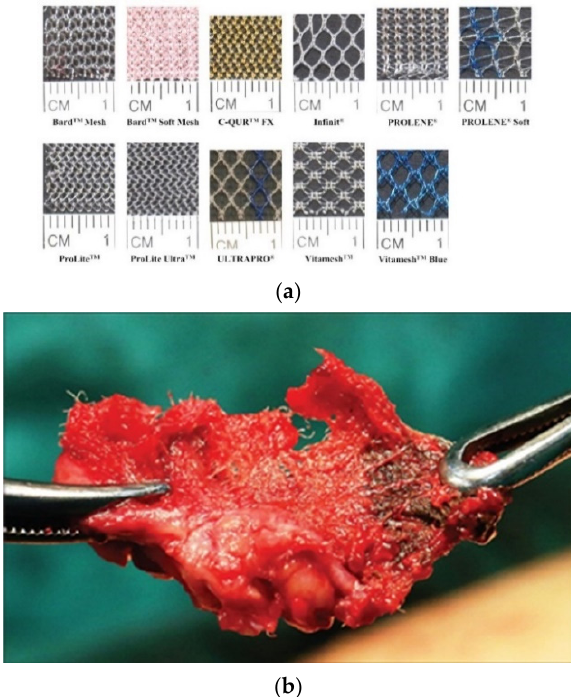
Figure 1. ( a ) Examples of different types of surgical mesh [1] and ( b ) a photograph of a piece of mesh, which was surgically removed after eroding through the wall of the patient’s bladder [2].